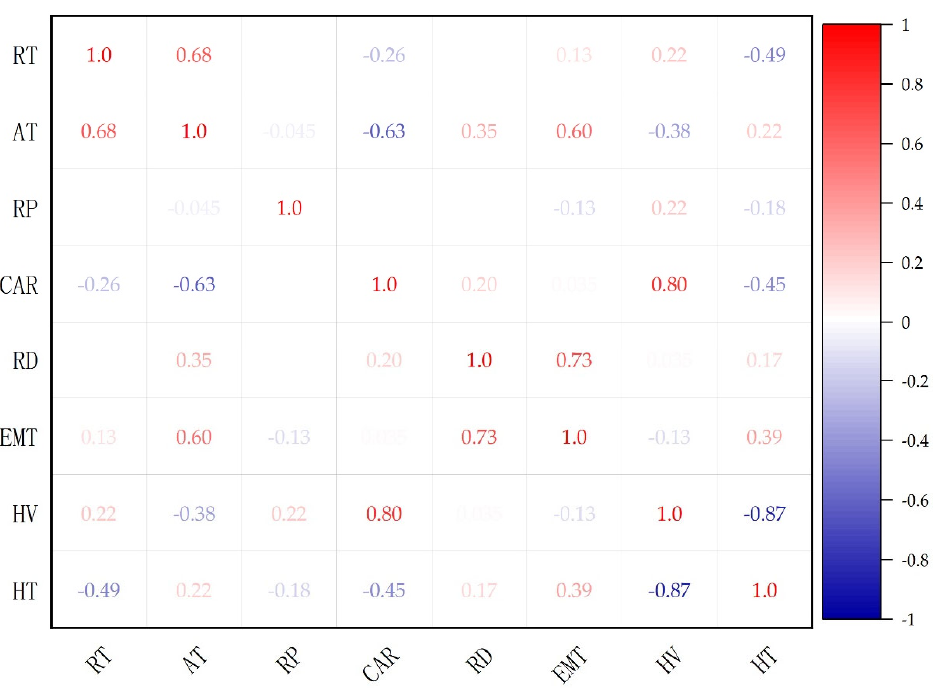
Figure 6. The Spearman’s Rank Correlation Coefficient results of HV and HT.